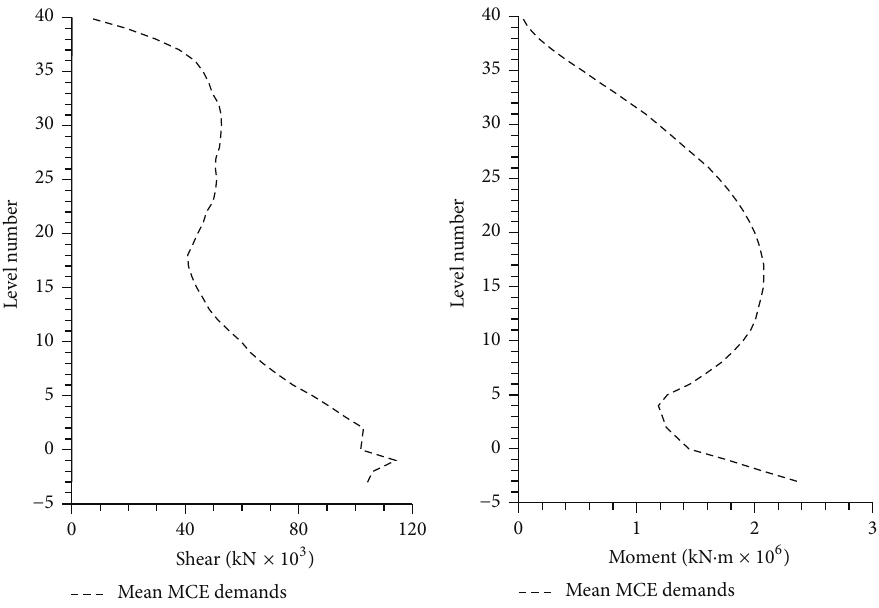
Figure 5: Inelastic MCE shear and moment demands in the controlled structure.